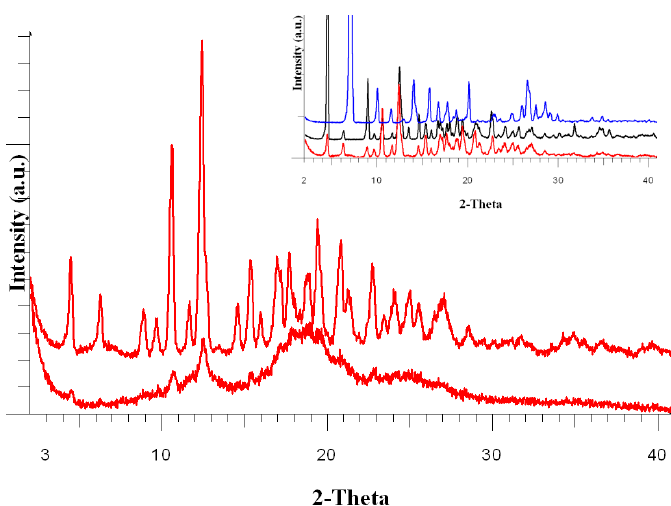
Figure 4. Wide-Angle X Ray Diffraction (WAXD) diffractograms of the DA: β CD (1:1) inclusion complex: after the freeze-drying process (red lower diffractogram) and after 18 h maintained in a water saturated atmosphere (red upper diffractogram). Insert: WAXD diffractograms of the DA: β CD (1:1) inclusion complex after 18 h maintained in a water saturated atmosphere (red), β CD peaks (black-middle diffractogram) and DA (insert, blue-upper diffractogram) .